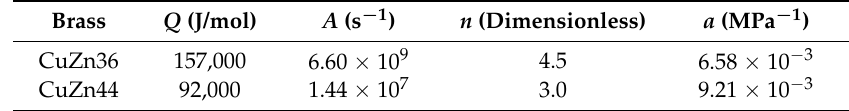
Table 1. Parameters of Equation (20) for the single-phase brasses, CuZn36 ( α -brass) and CuZn44 ( β